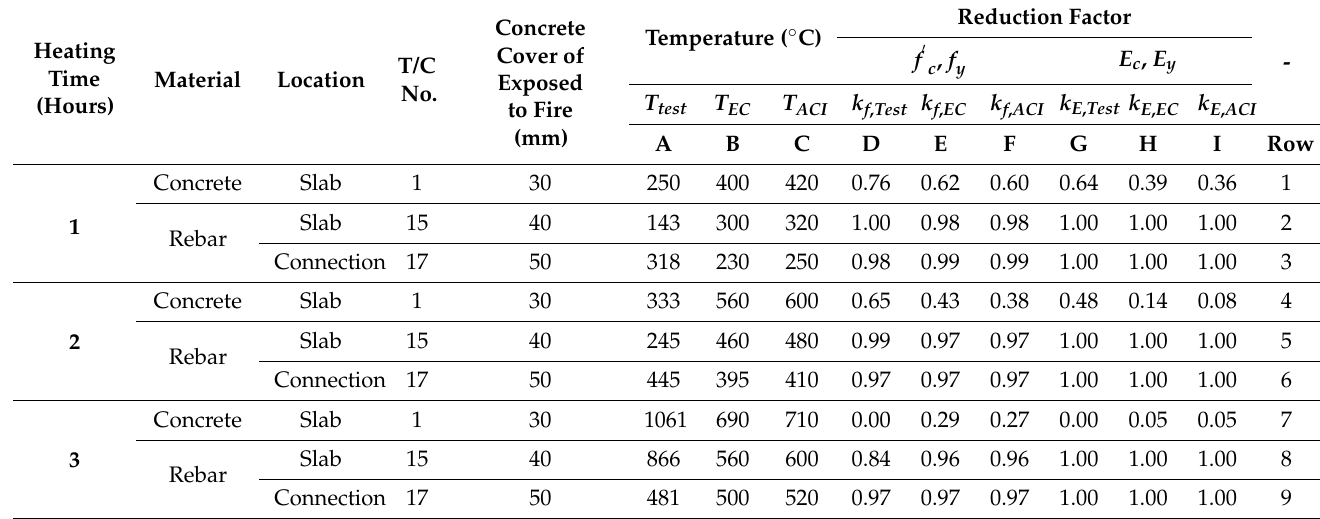
Table 10. Reduction factor ( k ) of concrete yield strength ( f (cid:48) elevated temperature (EN 1992-1-2 [17], ACI 216.1M-14